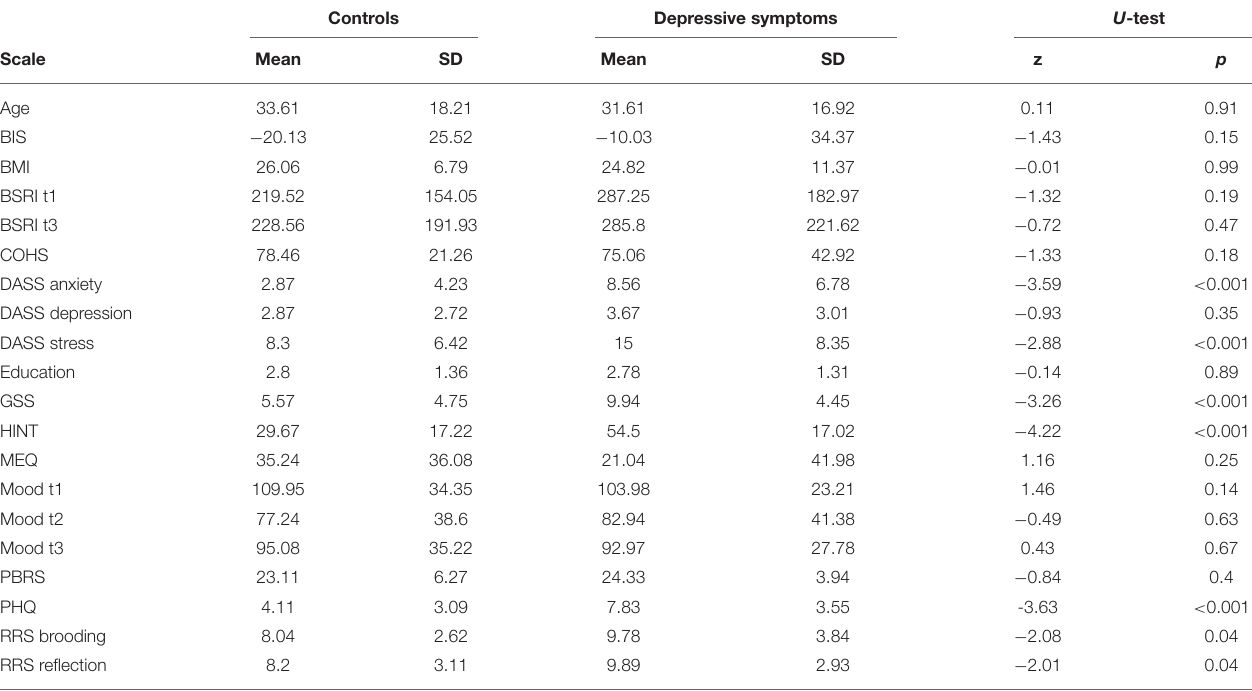
TABLE 1 | Self-reported characteristics of the control group and group with worsening of depressive symptoms in winter at baseline. Controls Depressive symptoms U -test